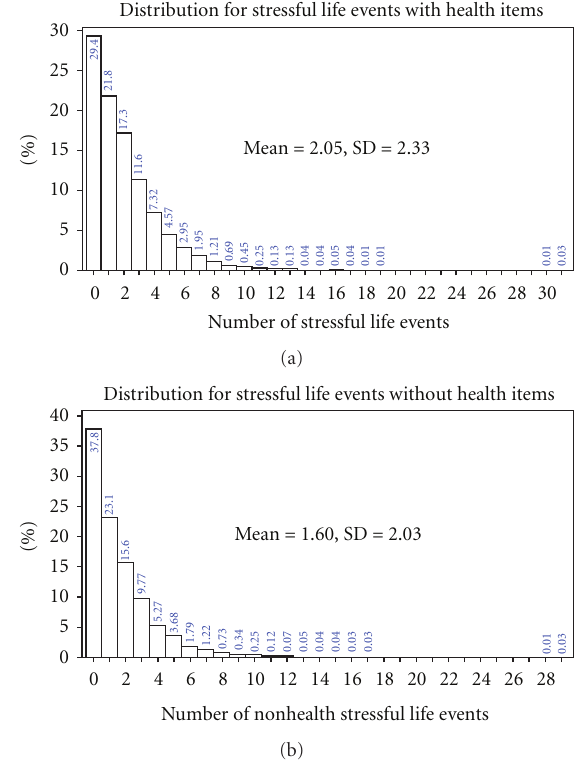
Figure 1: Distribution of the stressful life event